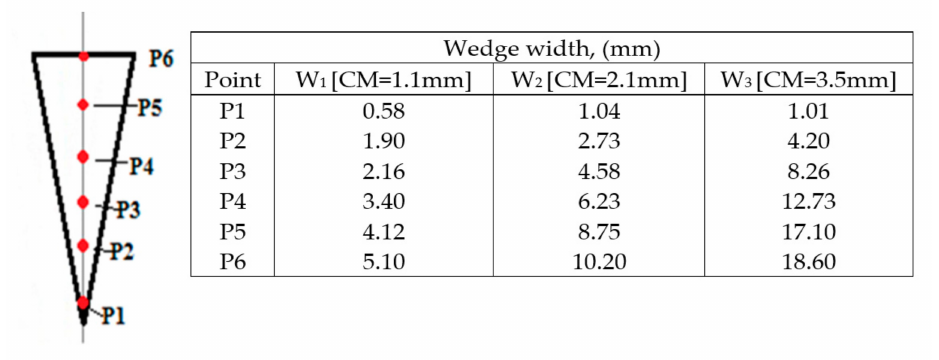
Figure 4. Analysed points on the height of the test wedge